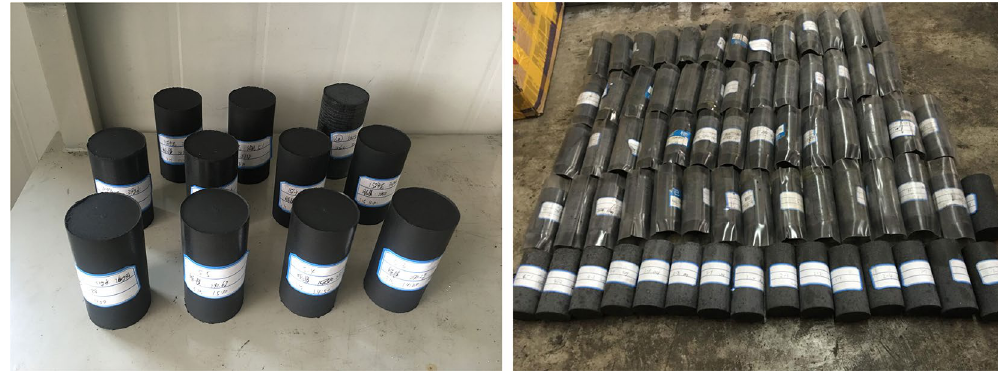
Figure 3. Specimens in